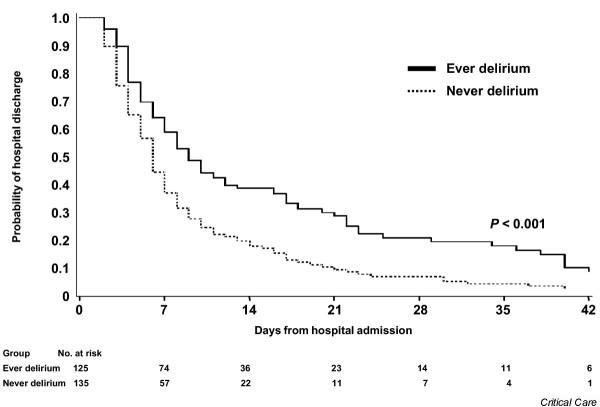
Delirium versus hospital length of stay. This Kaplan-Meier plot shows the relationship between delirium and hospital length of stay by classification of Ever Delirium versus Never Delirium (p < 0.001, univariate analysis).